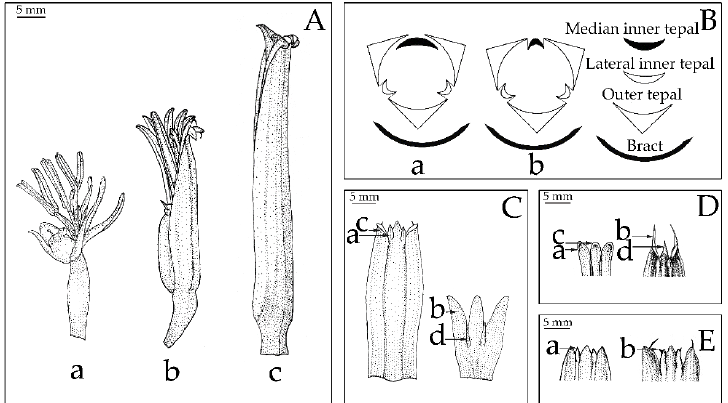
Figure 8. Compound tepal morphologies comparison and character state between Musaceae (char- acter no. 1–8), ( A ) shape of perianth: (a) fused tepal with deep lobes; (b) ventricose; (c) tubular, ( B ) symmetry of flower: (a) bilateral symmetry; (b) radial symmetry, ( C ) shape of tepal lobe: (a) acute outer tepal apex lobes; (b) round outer tepal apex lobes; (c) ovate lateral inner tepal lobes; (d) acicular lateral inner tepal lobes, ( D ) spine-like dorsal appendage on outer tepal lobe: (a) absent on lateral outer tepal lobes; (b) present on lateral outer tepal lobes; (c) absent on median outer tepal lobes; (d) present on median outer tepal lobes, ( E ) spine-like dorsal appendage on lateral inner tepal lobes: (a) absent; (b) present.